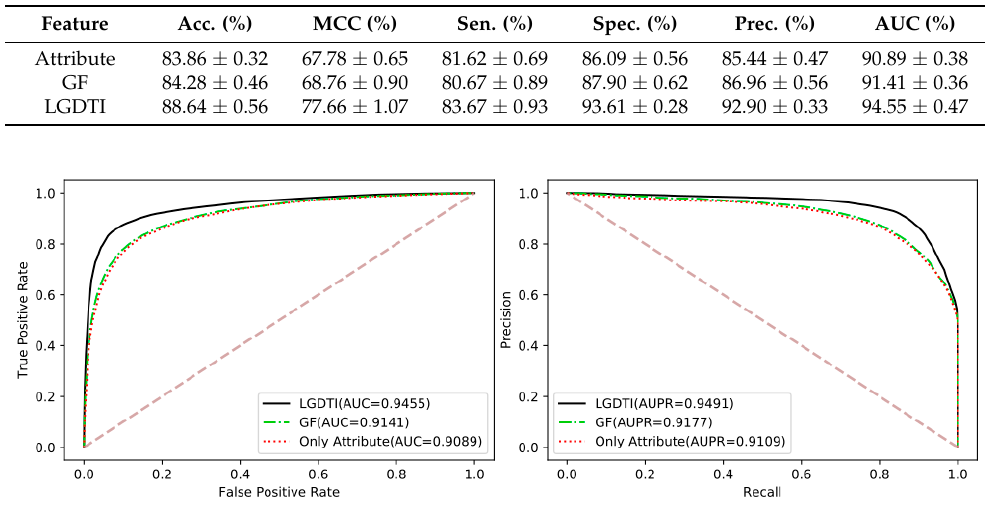
Figure 6. Comparison of the ROC and PR curves performed by random forest classifier based on different features.